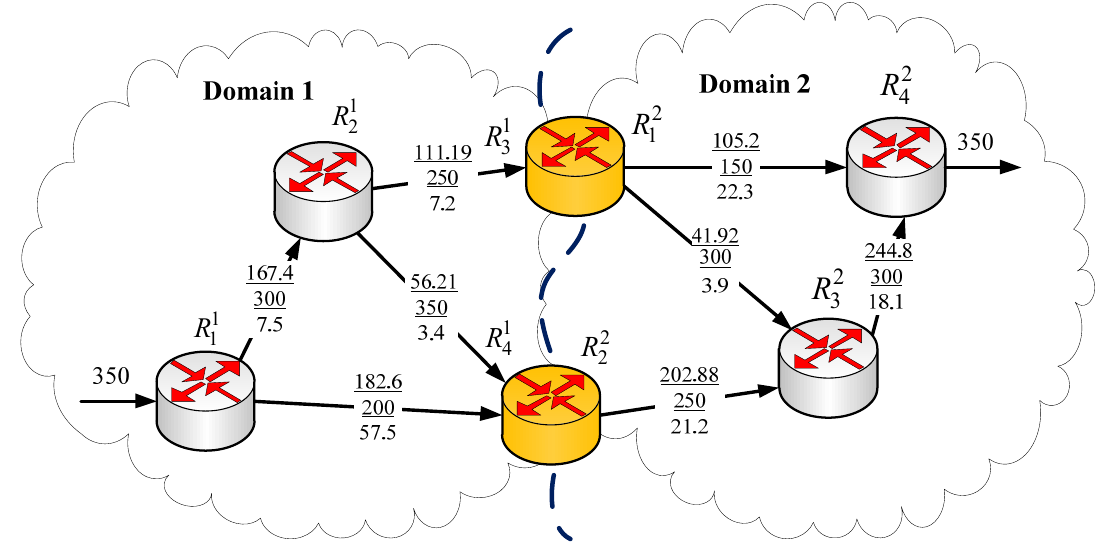
Figure 9. Solution to the inter-domain QoS routing problem after the first iteration of the coordination procedure following the normalized requirements (24).